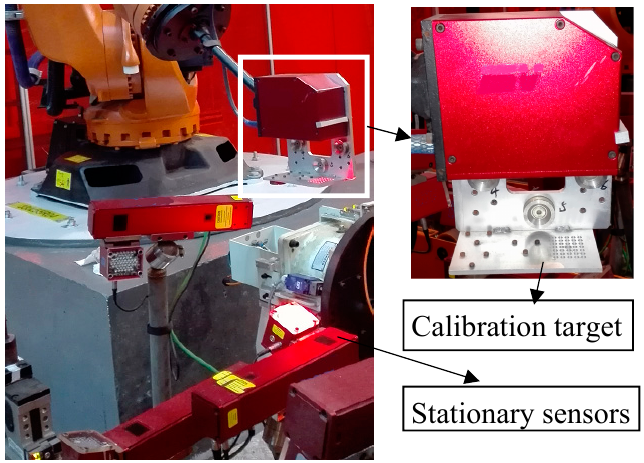
Figure 5. Global calibration of the stationary sensors.